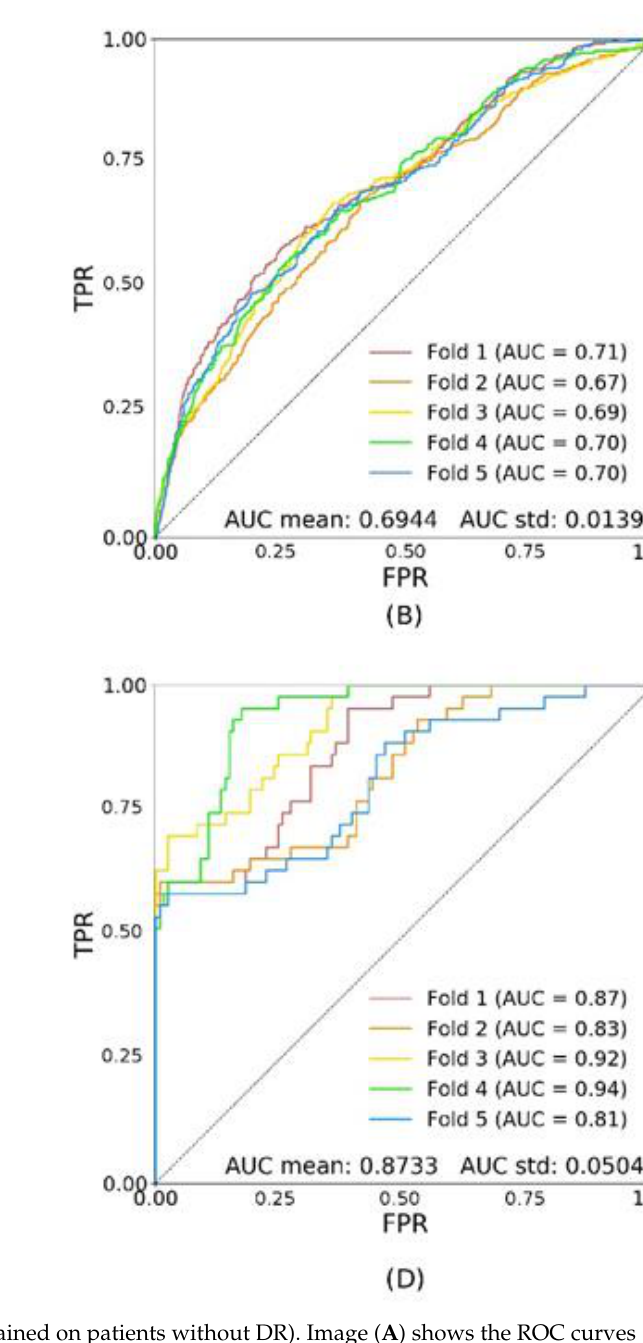
Figure 3. Shows the performance of the model trDR− (trained on patients without DR). Image ( A ) shows the ROC curves for the validation set (val); ( B ) shows the ROC curves for the test set with all patients (tsA); ( C ) shows the ROC curves for the test set with patients without DR only (tsDR−); ( D ) shows the ROC curves for the test set with patients with DR only (tsDR+).